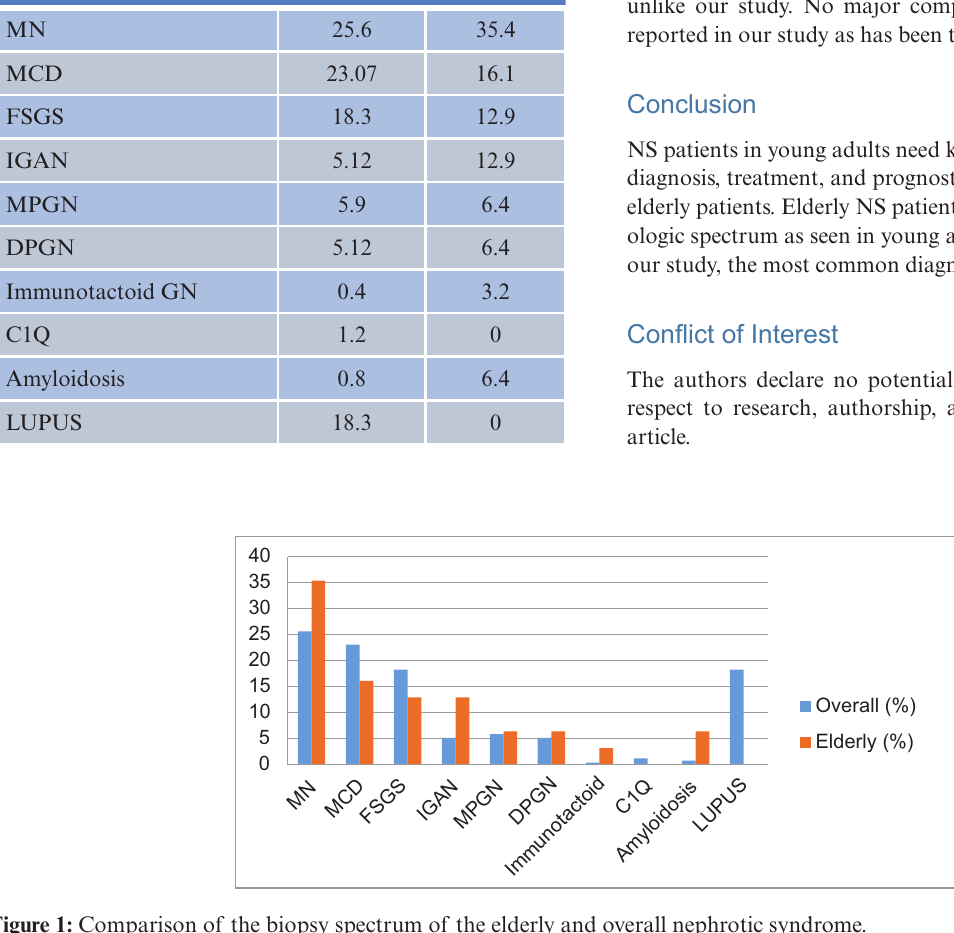
Figure 1: Comparison of the biopsy spectrum of the elderly and overall nephrotic